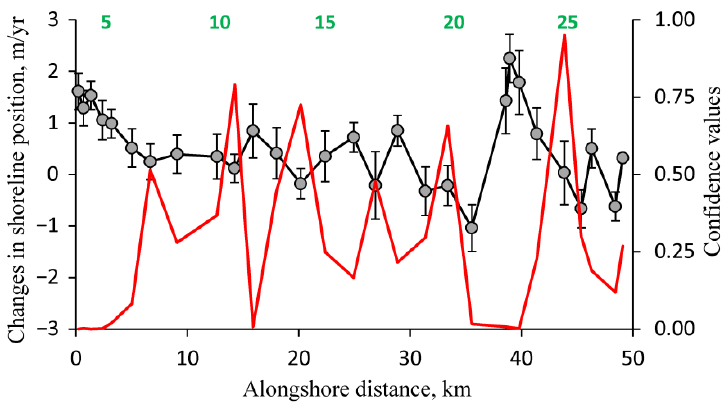
Figure 4. Linear trends (m / yr) in the shoreline position between 2002 and 2019. Red line—significance level ( p -value). Green labels indicate cross-shore profile numbers.